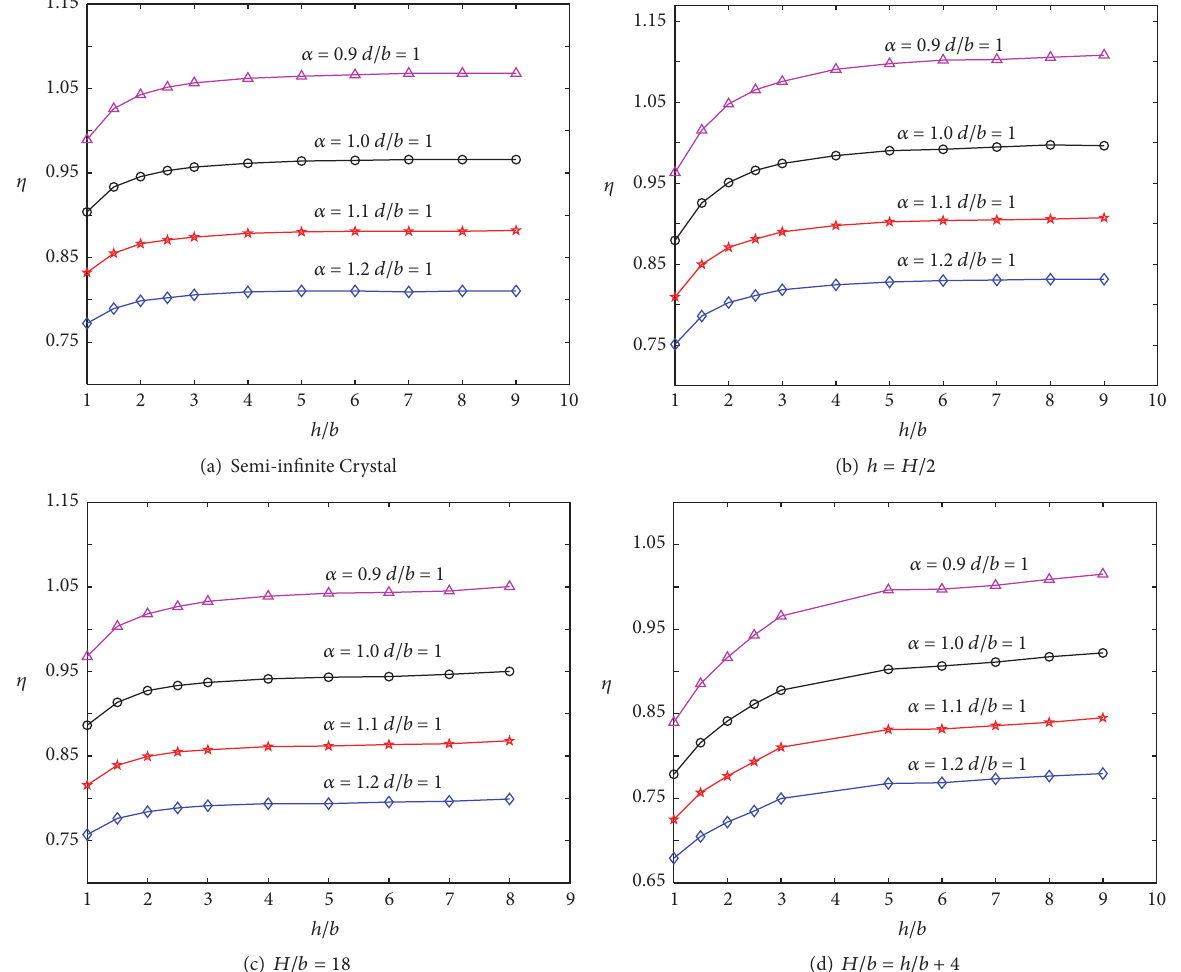
Figure 2: Variation of core structure parameter 𝜂 with respect to the dislocation’s distance to the surface for various normalized unstable stacking fault energy for screw